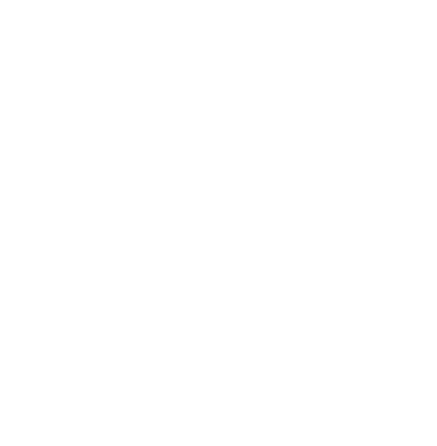
Figure 10. Contour view of the hydrostatic stress for the typical non-prismatic RC beam model B2 (hollow).